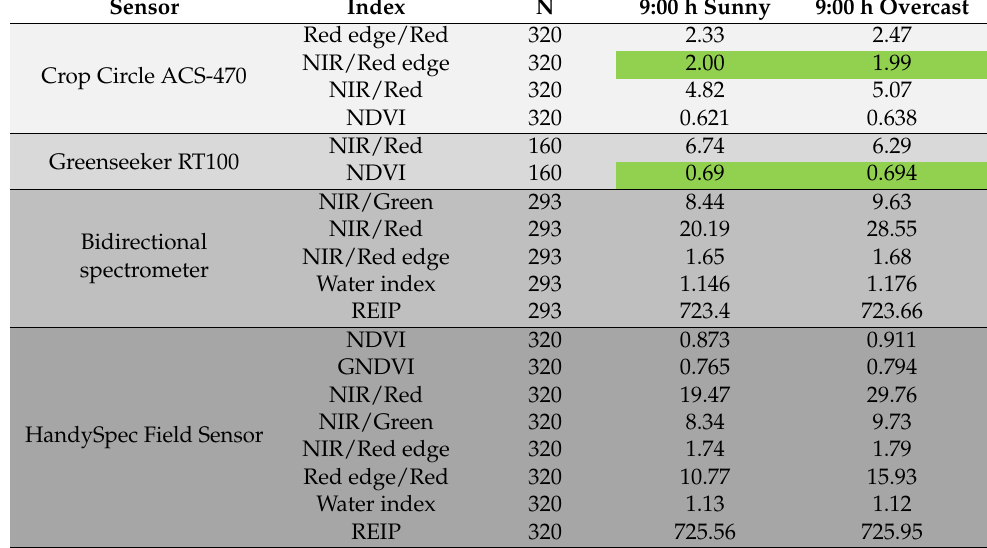
Table 8. Mean values of each vegetation index for paired measurement dates at 9:00 h on a sunny (08-05-2019) and overcast (07-05-2019) day measured with the vehicle-carried Crop Circle ACS 470, Greenseeker RT100, hyperspectral spectrometer, and the handheld hyperspectral HandySpec Field sensor in a wheat crop. Green shading indicates non-significant differences between paired measurement dates using t -Tests ( p < 0.05); all other pairs were statistically different. Sensor Index N 9:00 h Sunny 9:00 h Overcast Red edge/Red